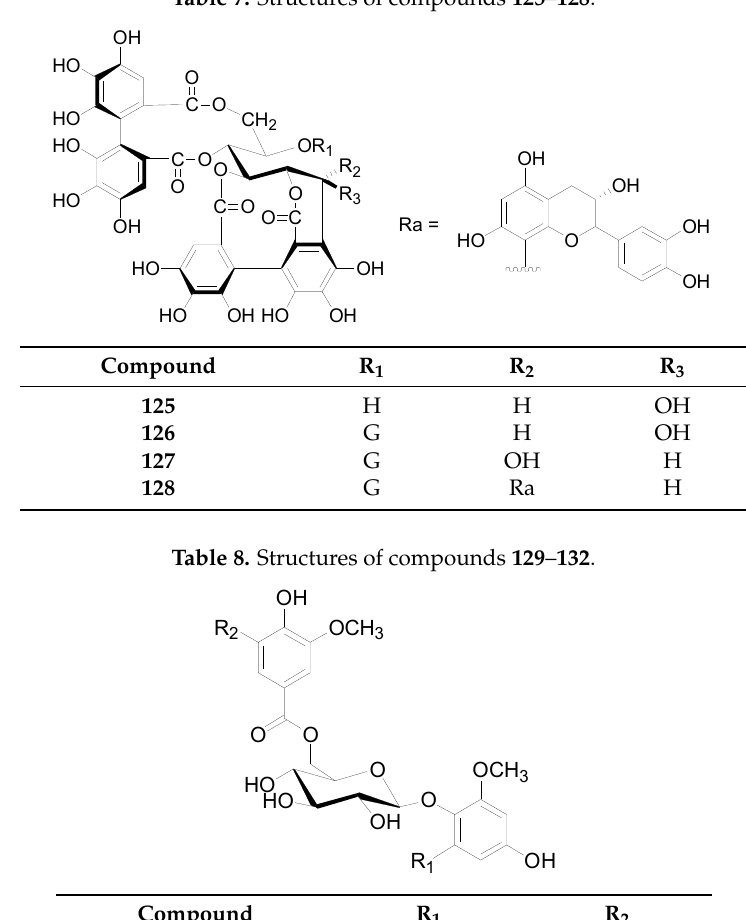
Table 7. Structures of compounds 125 – 128 .